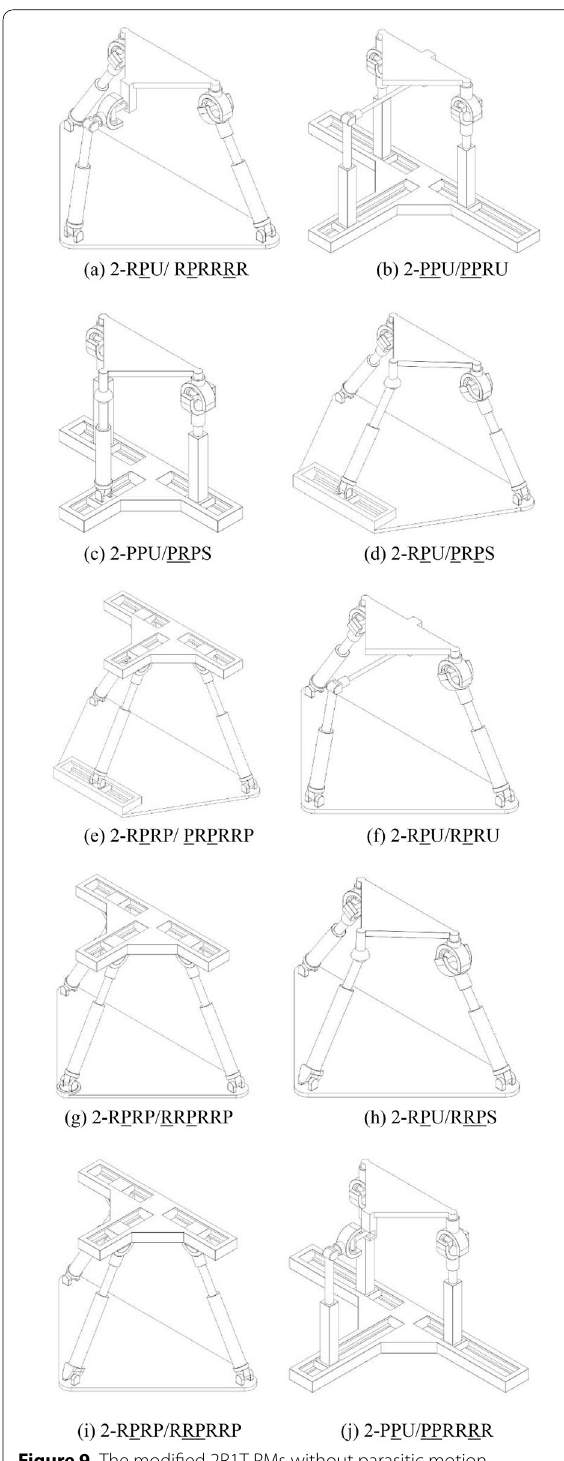
Figure 9 The modified 2R1T PMs without parasitic motion